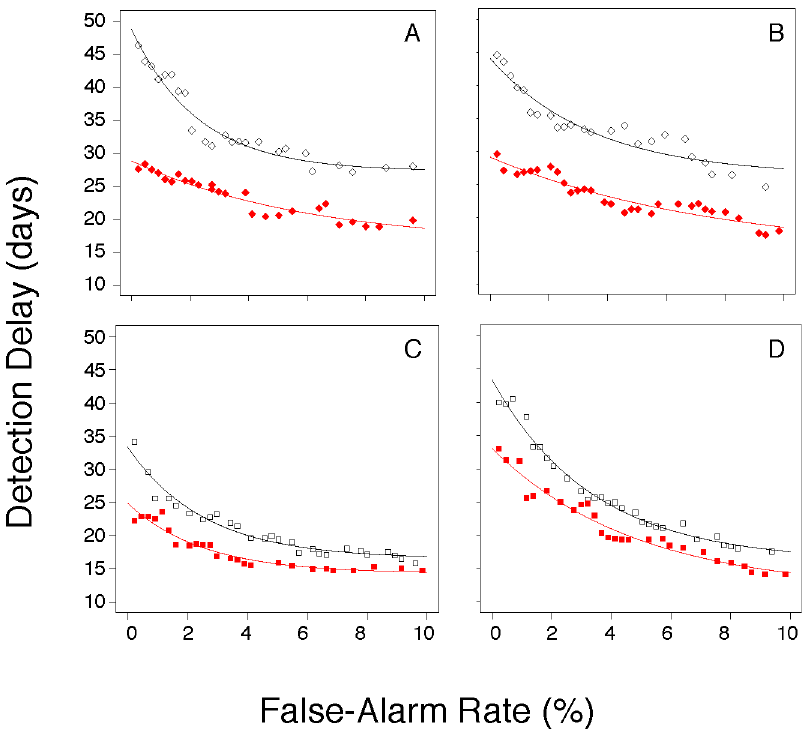
Fig 3. Performance comparisons: More realistic, semi-synthetic context. AMOC curves describing the performance of surveillance systems at detecting a modeled influenza epidemic injected into authentic backgrounds obtained by implementing CDA1 in 2002–2003 (panel A) or in 2003–2004 (panel B), and CDA2 in 2002–2003 (panel C) or in 2003–2004 (panel D). Outbreak detection methods were either EARS (open black symbols) or SARIMA (closed red